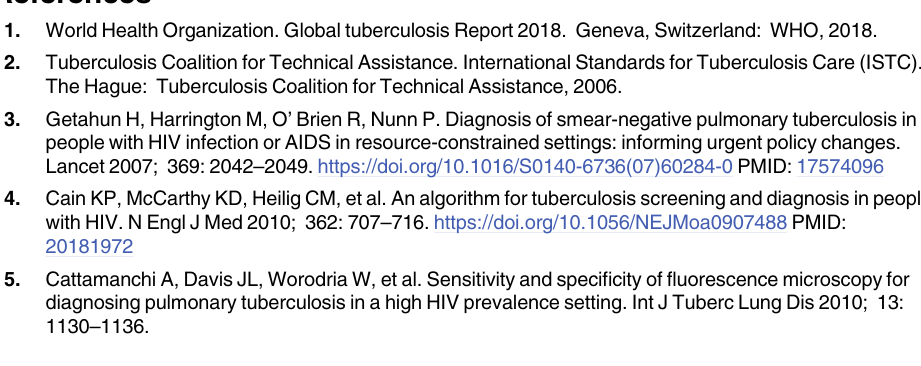
algorithm clinic&xpert sputum »; DALYavertedclinicxpertlam1 = « DALYs averted with